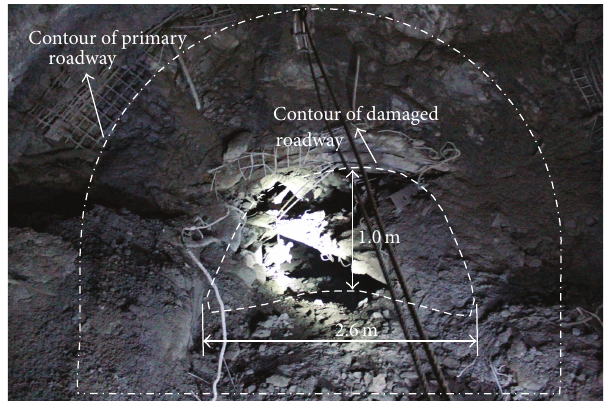
Figure 2: Large deformation of the roadway.